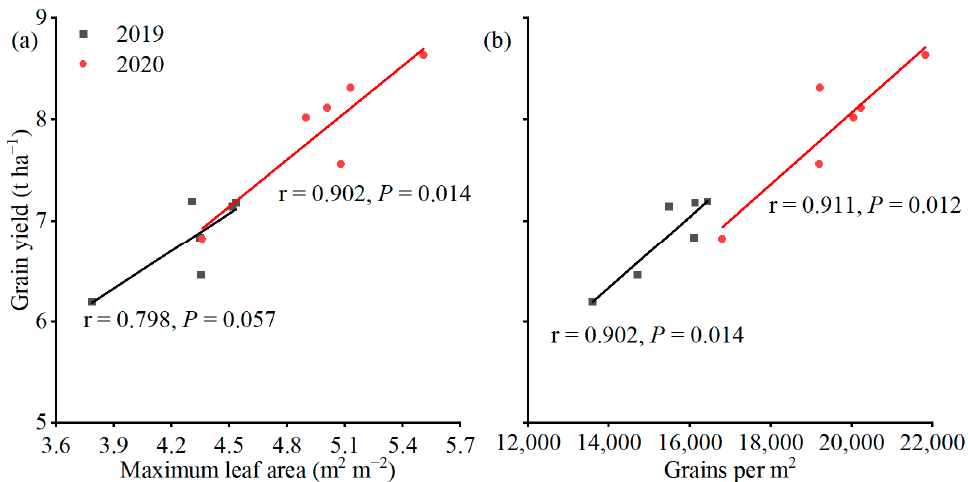
Figure 5. Relationship of ( a , b ) maximum leaf area and grains per m 2 with grain yield under different treatments for both growth seasons.